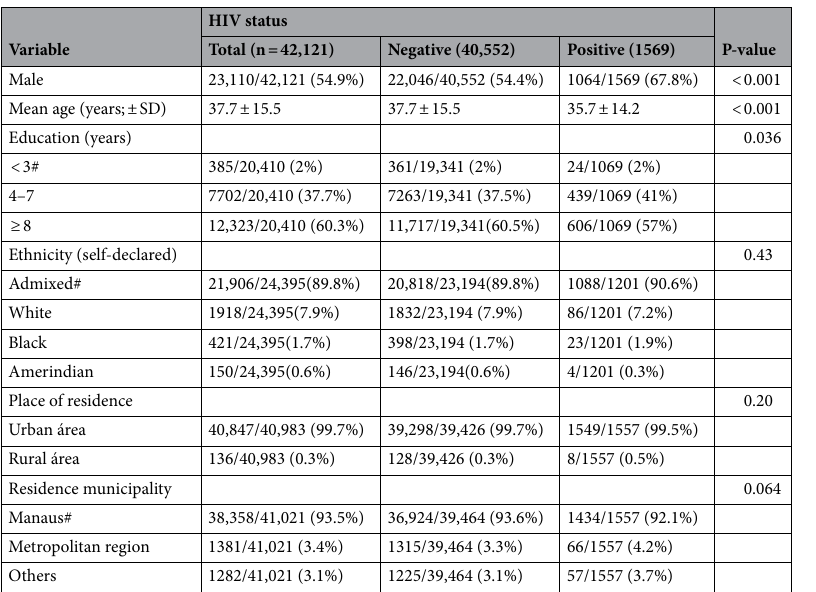
Figure 1. Flowchart of participants’ inclusion and linkage between HIV status and malaria episode databases, Amazonas state, Brazil.